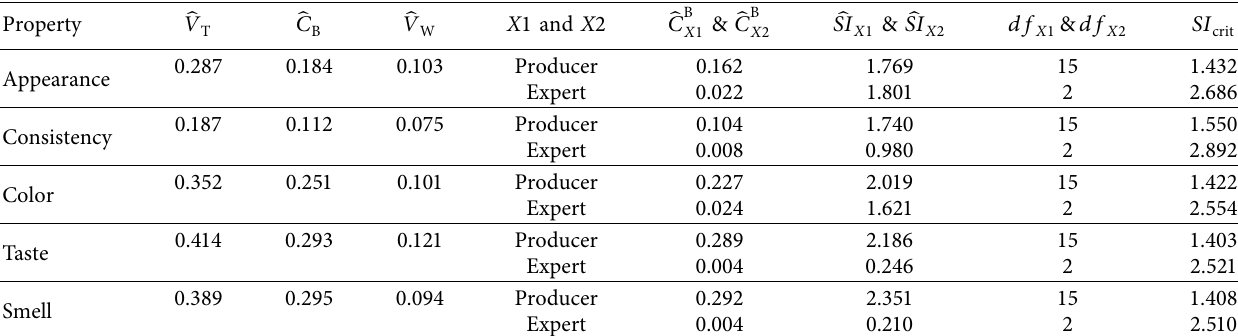
Table 2: Results of two-way ORDANOVA without replication for the sensory responses on the property of